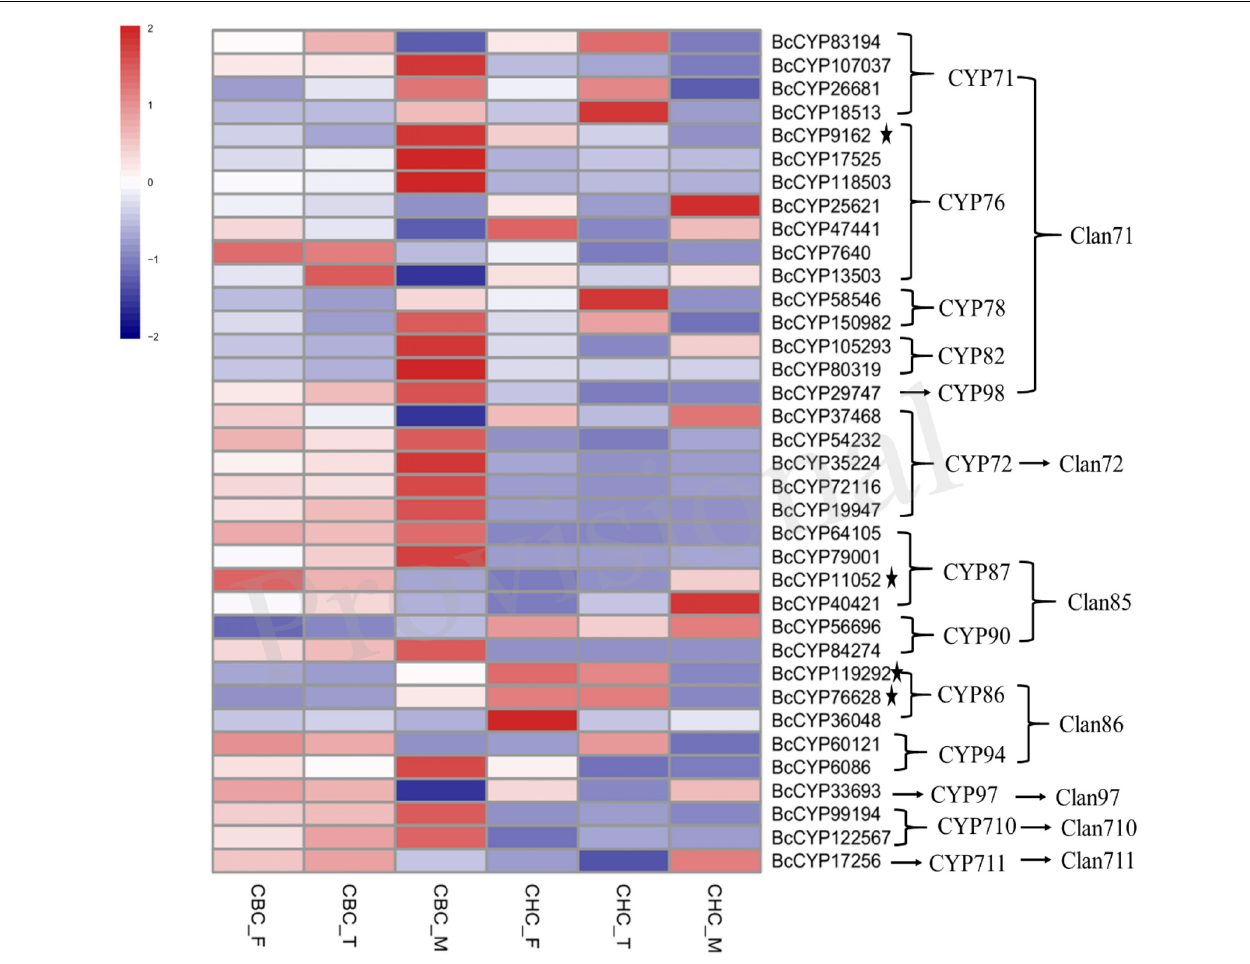
FIGURE 2 | Gene expression profiles of candidate P450s involved in the biosynthesis of triterpenoid saponins. All these genes showed significantly differential expression in S3 of Bupleurum chinense DC. The genes with asterisks also showed significantly differential expression in S3 of Bupleurum scorzonerifolium Willd. The sample information is listed in Figure 1